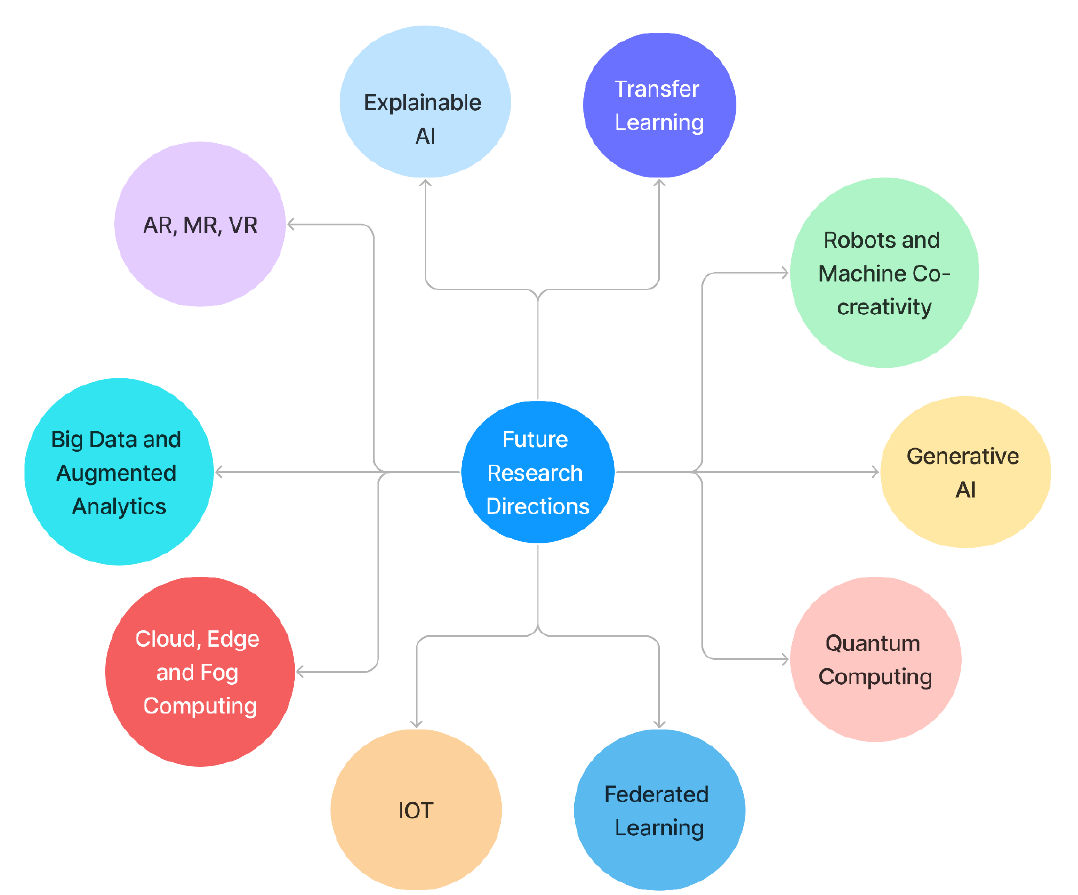
Figure 8. Future research directions—Parkinson’s disease diagnosis.